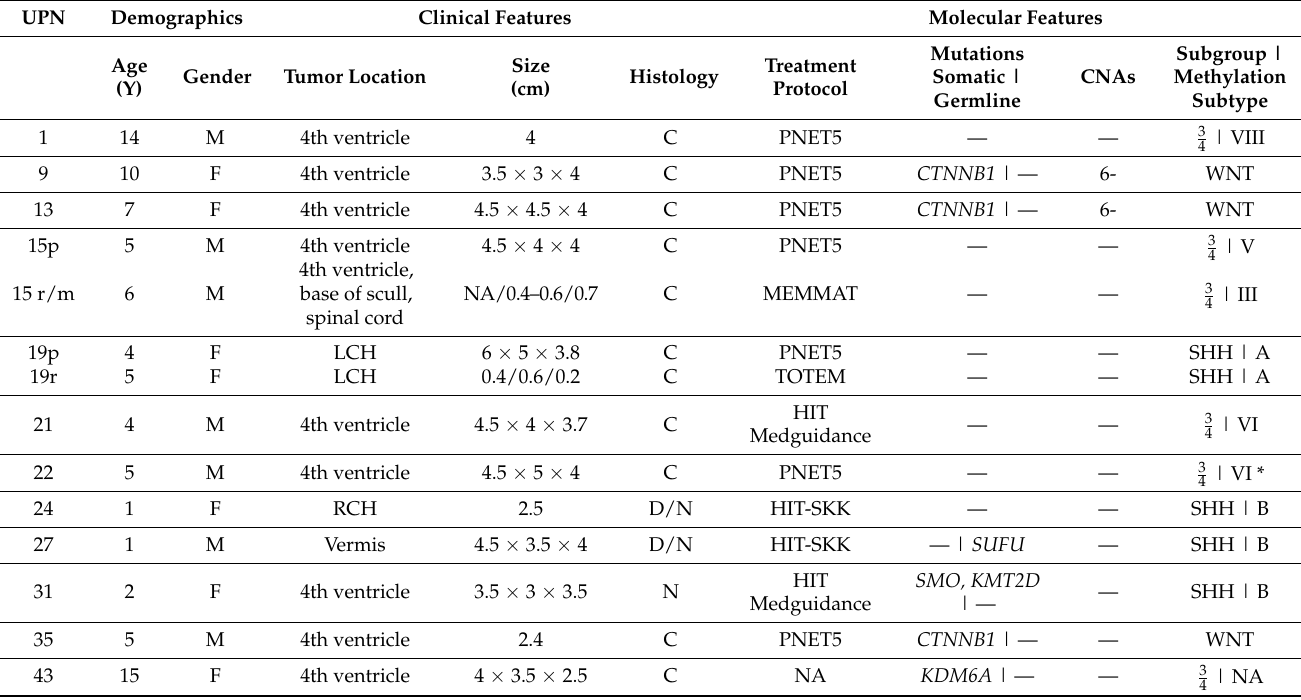
Table 1. Participants’